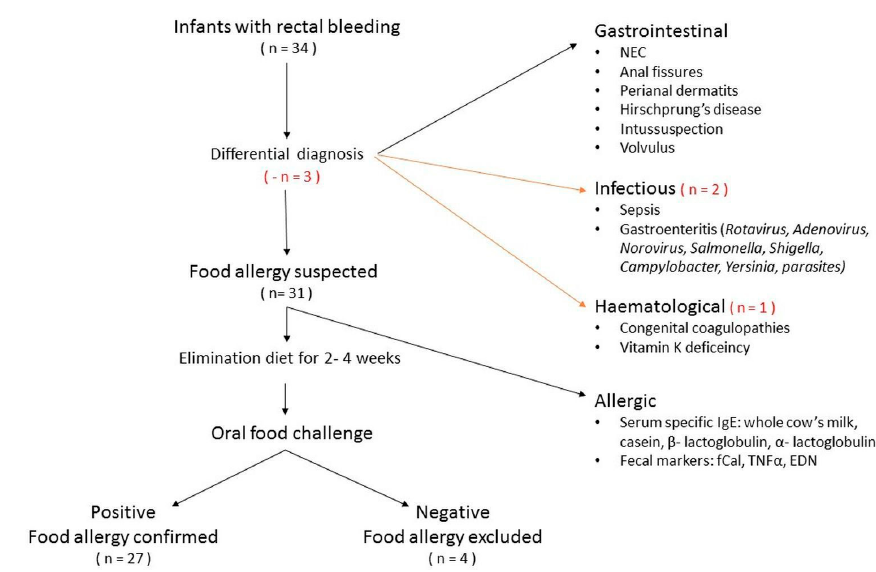
Figure 1. Study design. EDN, eosinophil derived neurotoxin; fCal, fecal calprotectin; NEC, necrotizing enterocolitis; TNF α , tumor necrosis factor α .